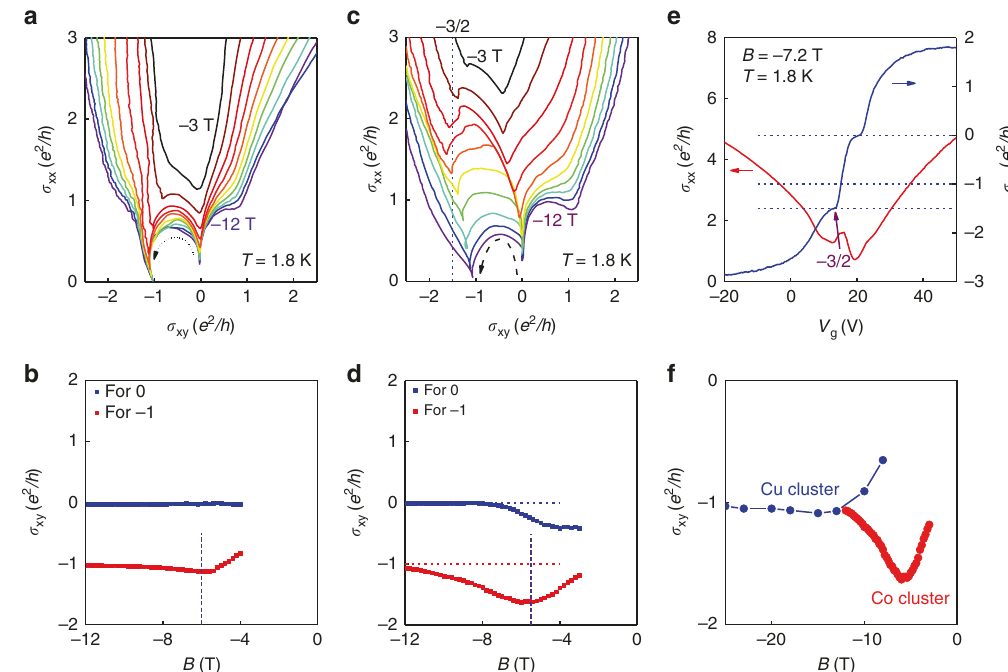
Fig. 2 Renormalization group fl ow diagram analysis with the result of quantization trajectory of single Dirac channel. a Renormalization group fl ow diagram (RGFD) analysis in ( σ xy , σ xx ) space based on the data measured between − 3 and − 12 T with the step being − 1 T for the sample before the Co deposition (sample A ′ ) at 1.8 K. The converging points (CVPs), the local minimum with a vanishing σ xx and plateau σ xy , indicate complete quantum Hall (QH) fi lling. b We note two sets of CVPs, pointing to σ xy of 0 and − e 2 /h . The dashed line marks the σ xy minimum. c RGFD analysis in ( σ xy , σ xx ) space based on the data measured between − 3 and − 12 T with a step of − 1 T for the Co-decorated sample (sample A). Note the anomalous RGFD trajectory is characteristic in this system. d The CVP trajectories for sample A. The converging trajectories are clearly different. The dashed line marks the σ xy minimum. e The 3/2 QH plateau observed at − 7 T and 1.8 K, while scanning the gate voltage. f The CVPs of the − 1 plateau for the Cu clusters decorated BSTS (sample D) and the Co clusters decorated BSTS (sample A). Sample D does not show the anomalous trajectory of sample